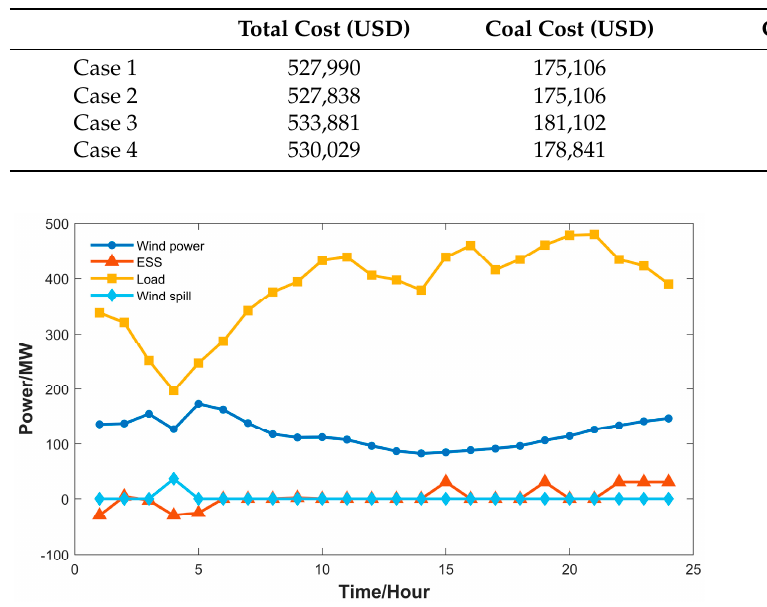
Figure 3. System operation result in Case 1.